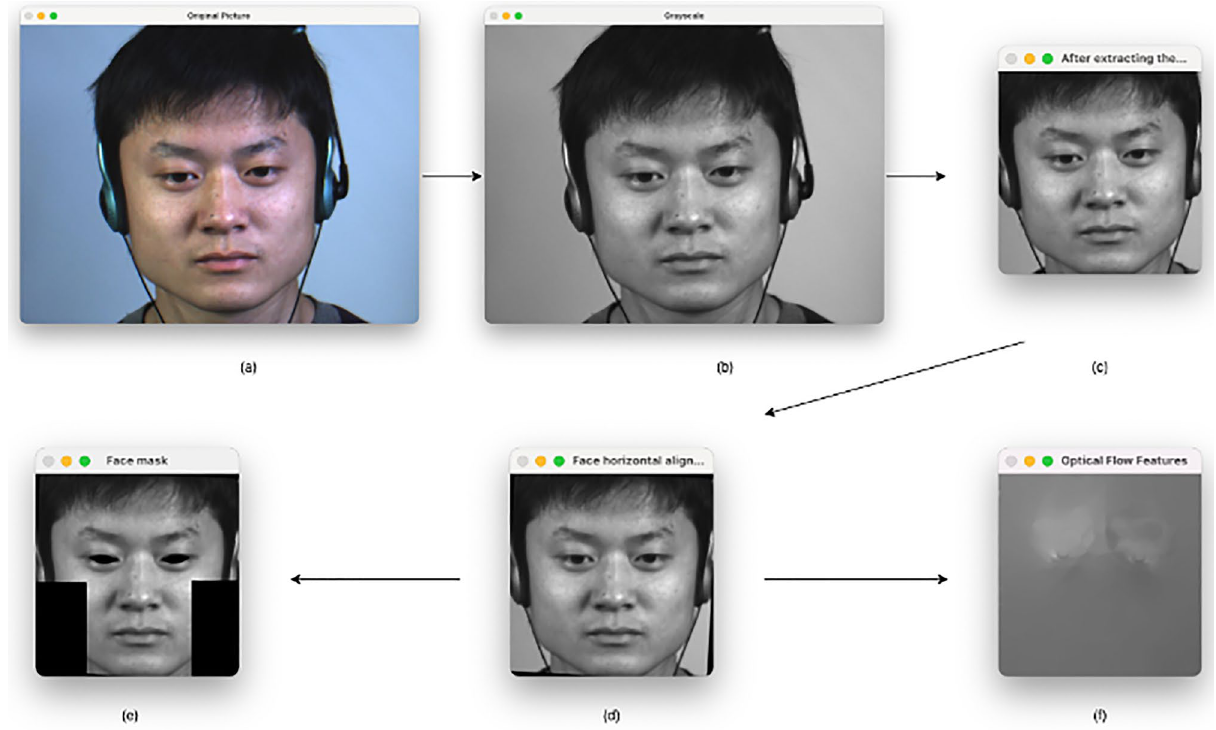
Figure 2. ( a ) Raw image. ( b ) Grayscale processing of the raw image. ( c ) Extracting the face and cropping the size. ( d ) Rotating the face to horizontal. ( e ) Adding facial masks. ( f ) Extracting optical flow features. Images are from subject 1 of the CASME II dataset 6 and is reproduced here following the CASME2 license agreement. Copyright © Xiaolan